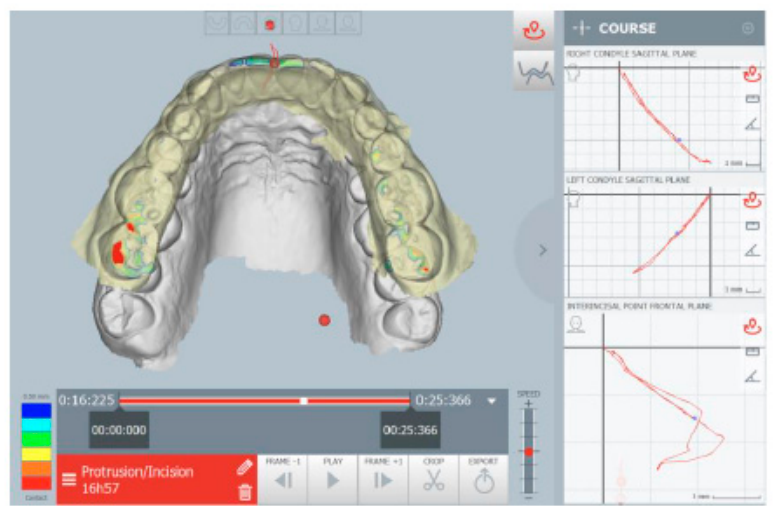
Figure 7. Occlusal contacts during mandibular protrusion movement. The red points indicate an abnormal contact during protrusion.